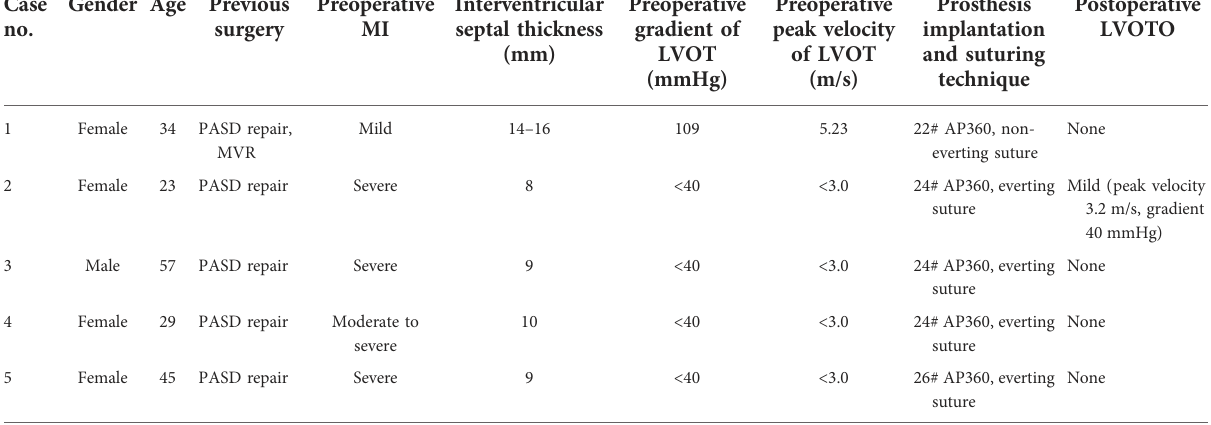
TABLE 1 Clinical data of fi ve patients. Case